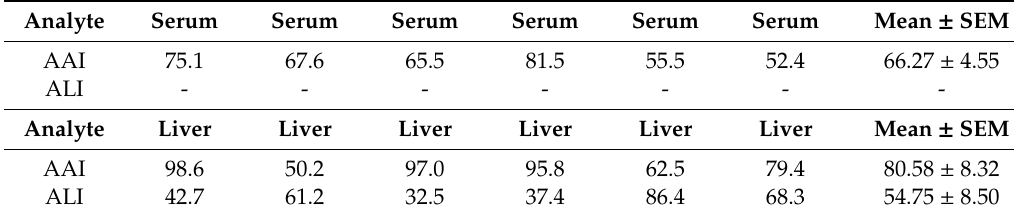
Table 5. The level of AAI and ALI (ng / mL) in serum and liver in the AA group ( n = 6).